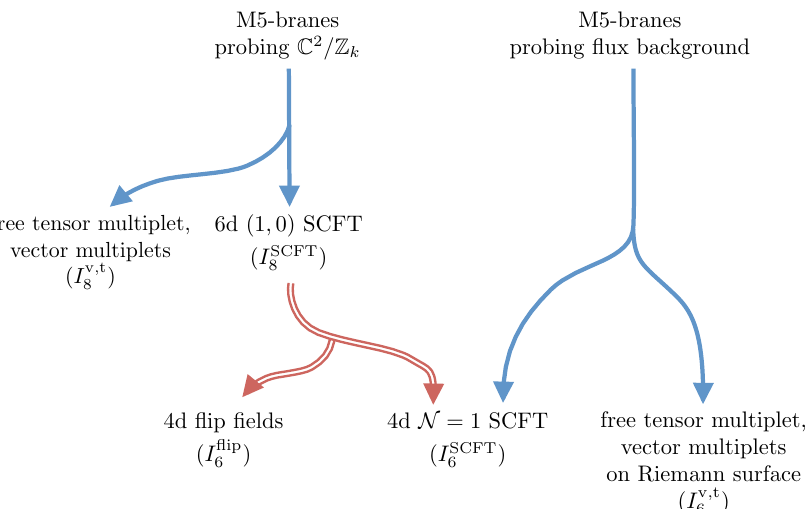
Figure 1. Schematic depiction of the flows across dimensions considered in this work. On the left: a stack of M5-branes with flat 6d worldvolume probes a singularity, yielding a 6d (1,0) C 2 / Z k SCFT, plus 6d modes associated to free tensor, vector multiplets. The interacting 6d (1,0) SCFT is reduced on a Riemann surface with fluxes. The outcome is organized into an interacting 4d SCFT, and a collection of 4d free fields, interpreted as flip fields. On the right: a stack of M5-branes probes a resolved singularity and is wrapped on a Riemann surface. At low energies, this M-theory C 2 / Z k setup gives the same 4d SCFT, plus other 4d modes coming from free tensor, vector multiplets on the Riemann surface. The blue, solid arrows denote anomaly inflow from the 11d bulk onto the M5-branes. The red, hollow arrows denote the purely field-theoretical reduction of the 6d (1,0) SCFT on the Riemann